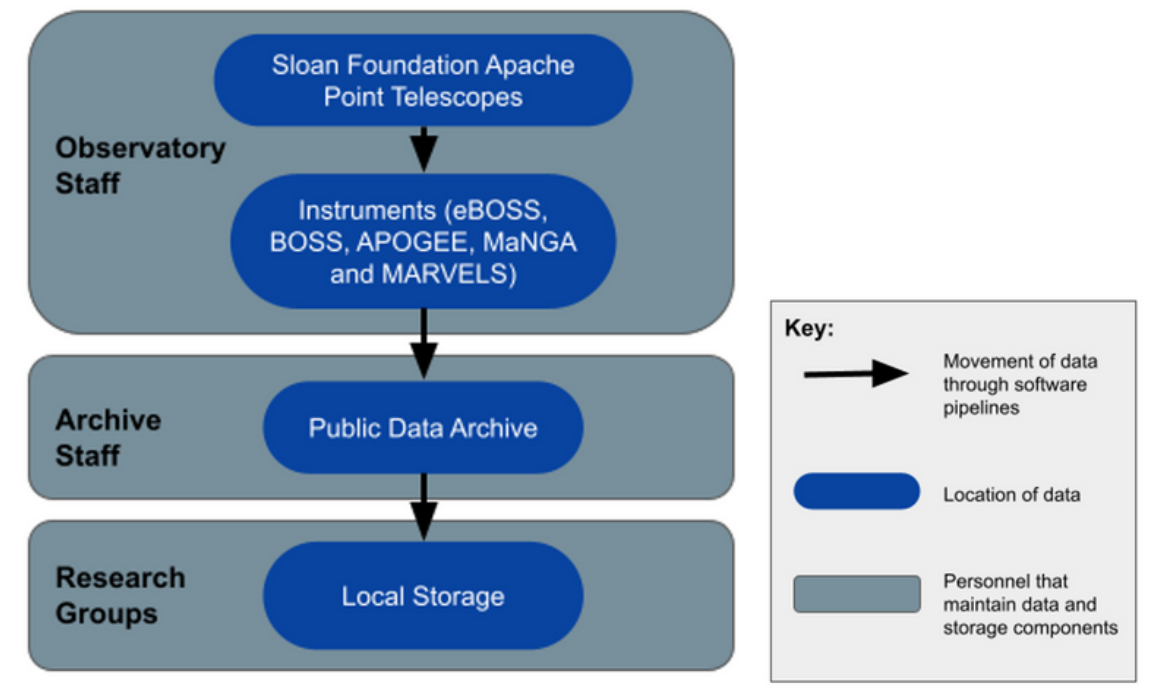
Figure 2. Overview of SDSS data processing